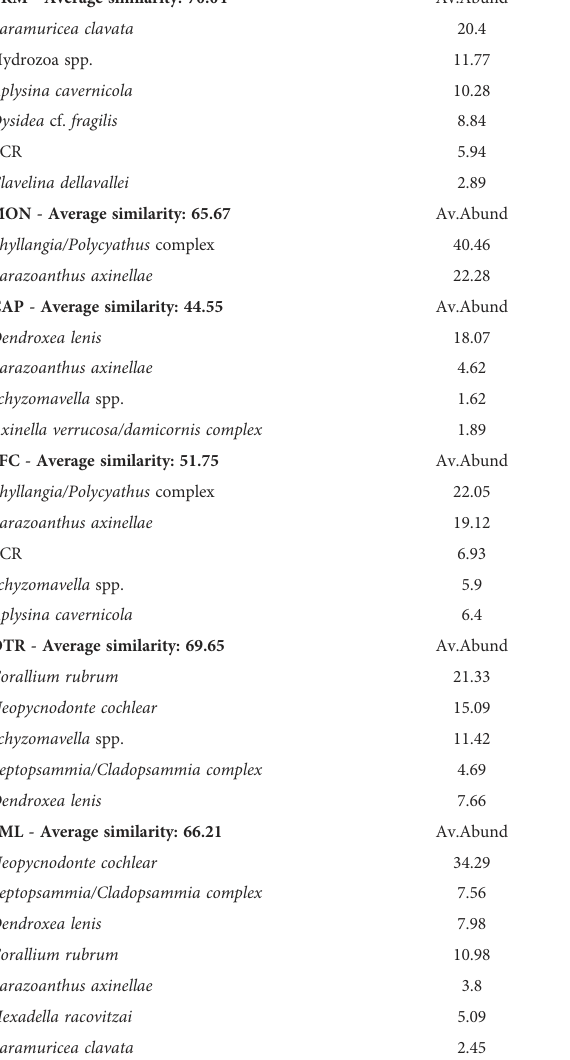
TABLE 2 Similarity percentage (SIMPER) analysis with cutoff criterion for species covering at 90%. TRM - Average similarity: